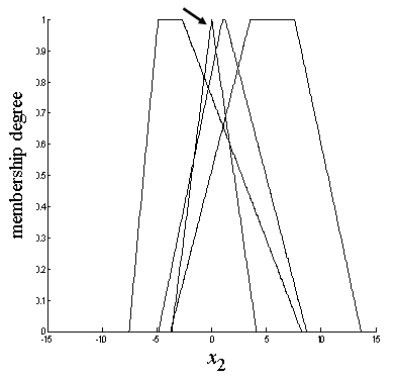
Fig. 8. FS “nearly zero” for variable x 2